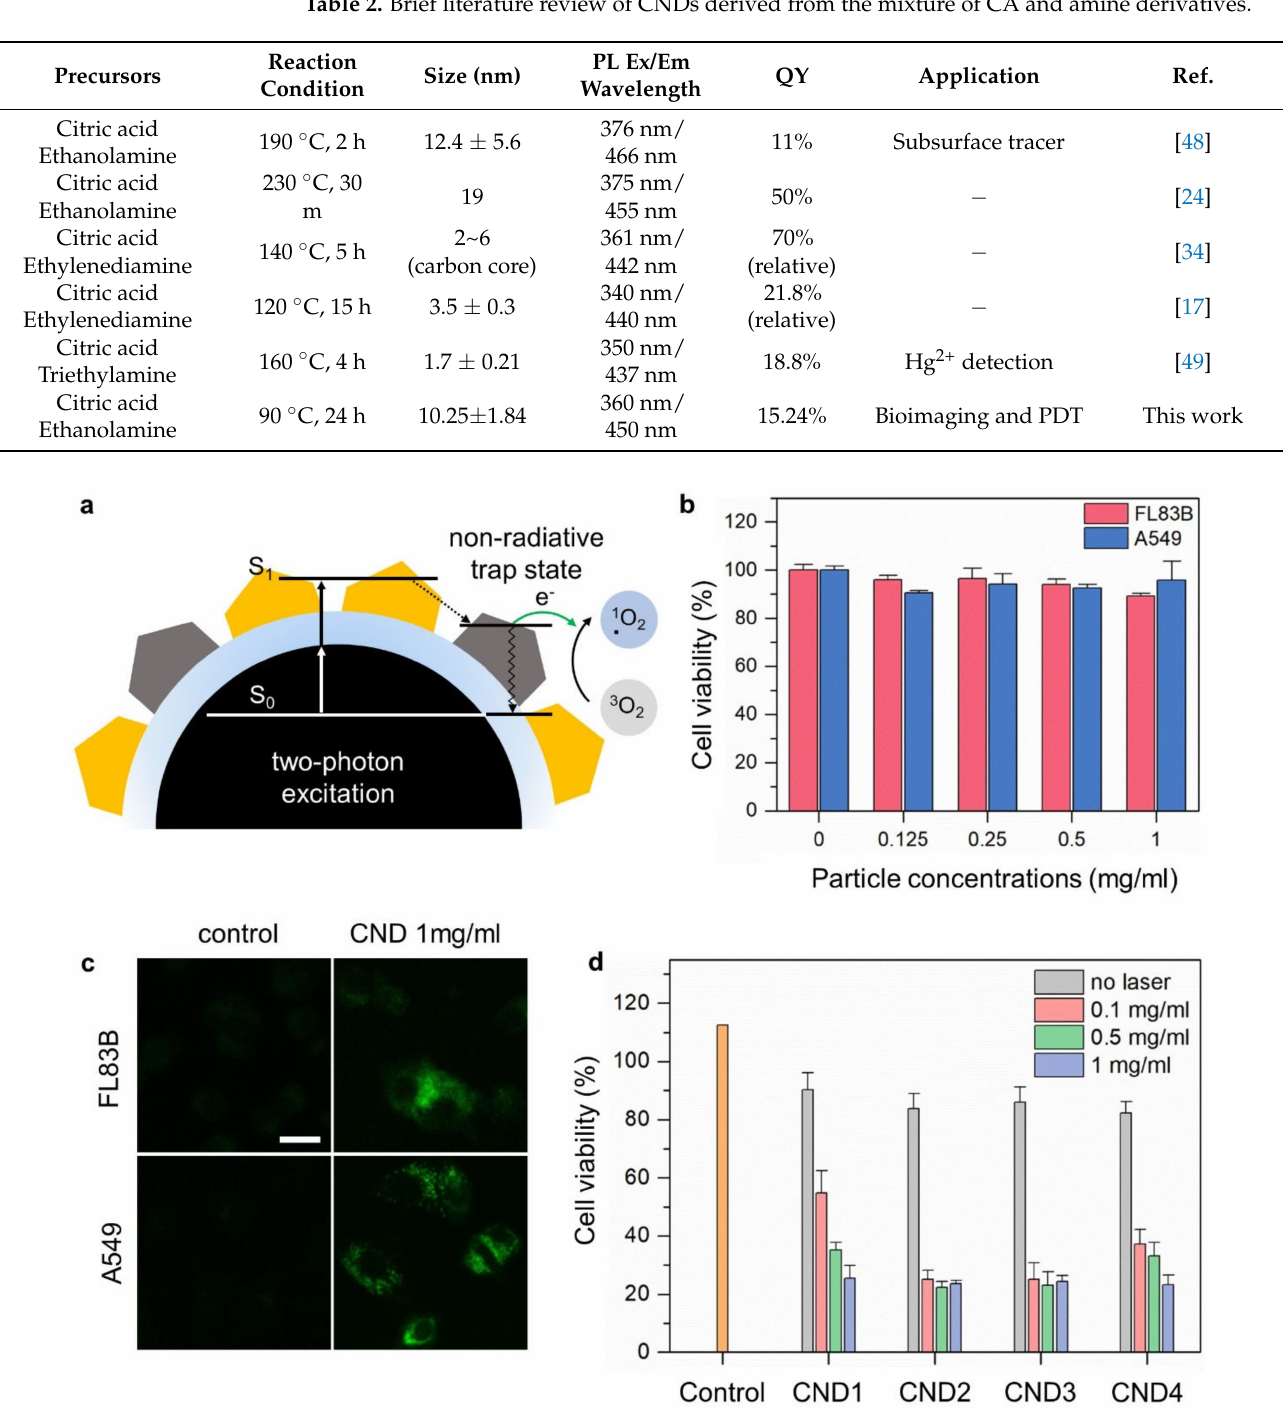
Figure 5. ( a ) Schematic illustration of the ROS generation by CNDs. ( b ) Cell viability test of the CNDs in FL83B and A549 cells using the WST-1 assay. ( c ) In vitro confocal microscopy images of FL83B and A549 cells with CNDs. The scale bar represents 25 µ m. ( d ) Cell viabilities of A549 cells measured by the CCK-8 assay after photodynamic treatment at different concentrations of the CNDs. The error bars are obtained from three independent experiments and represent the standard